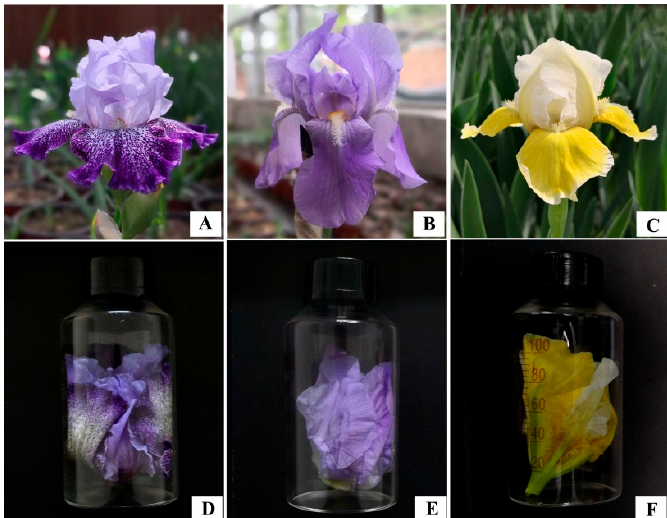
Figure 4. Photos of the representative accession for each of the three bearded iris species while flowering and inside 100 mL vials used for headspace extractions. ( A , D ) I. germanica ‘Splashacata’; ( B , E ) I. pallida ‘Dalmatica’; ( C , F ) I. pumila ‘Dash